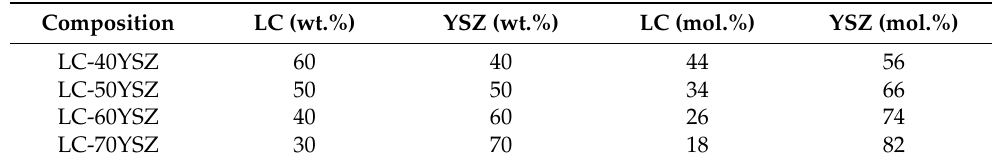
Table 1. Designation of the prepared LC-YSZ